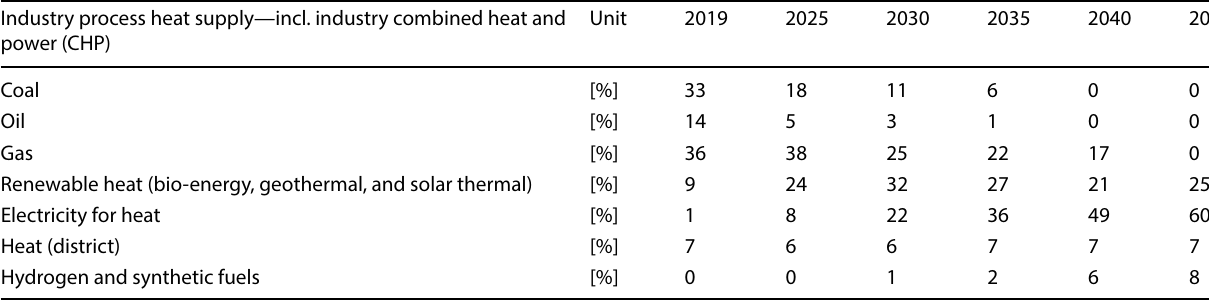
Table 19 Heat supply under the OECM 1.5 °C pathway Industry process heat supply—incl. industry combined heat and power